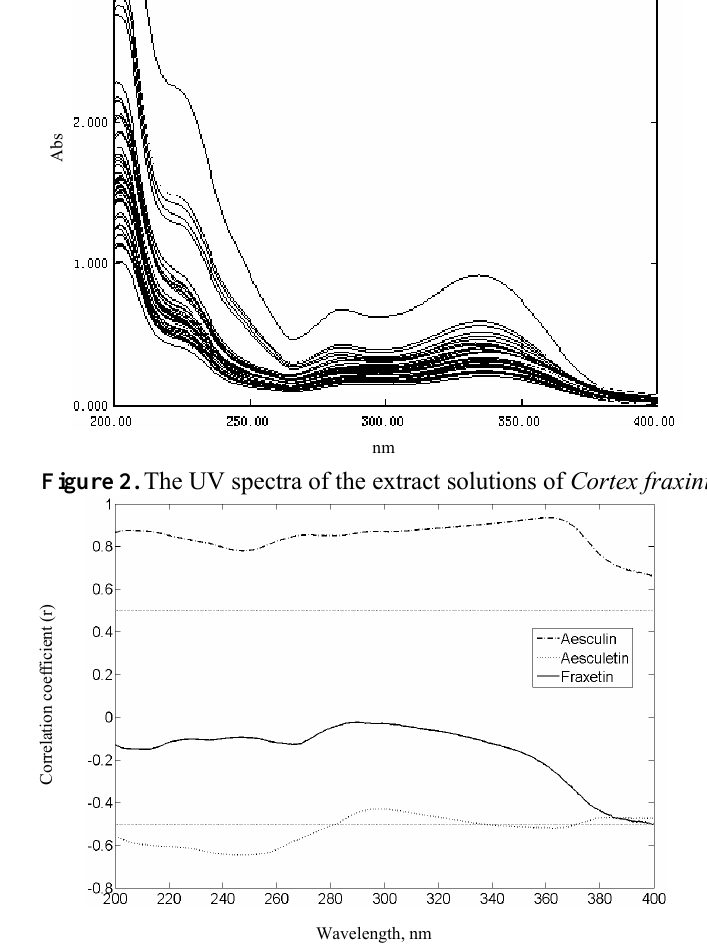
Figure 3. Correlation coefficients between absorbance at each wavelength and the reference concentration of the